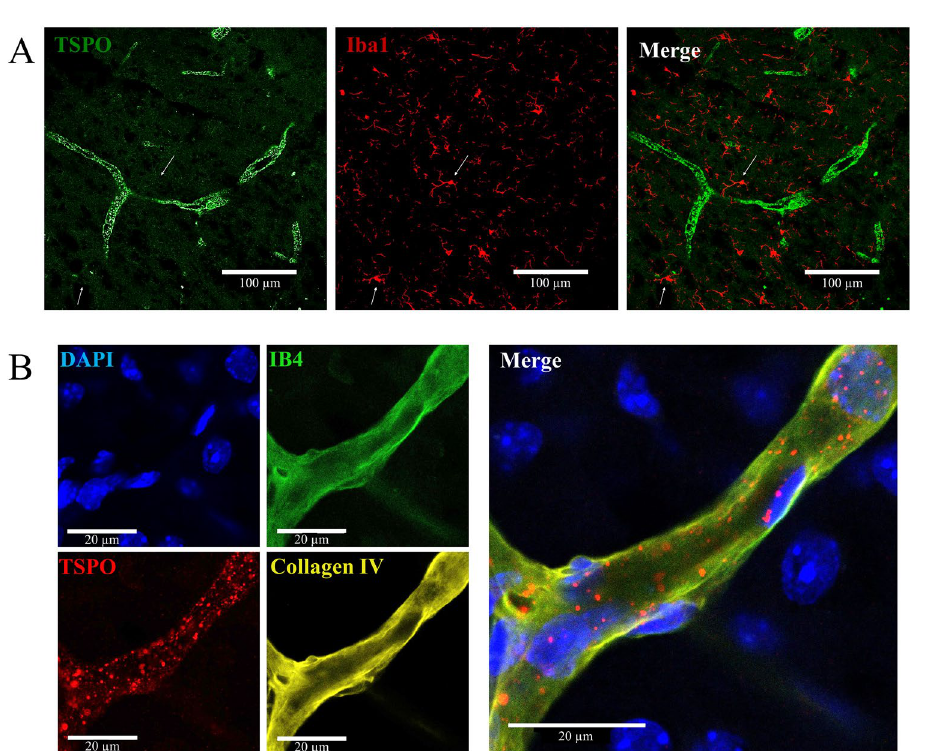
Figure 2. Immunohistochemistry on mouse brain slice 3 days post-TBI around ipsilateral cortical area, ( A ) Iba1/TSPO staining; ( B ) DAPI/TSPO/IB4/Collagen IV staining. TBI traumatic brain injury, TSPO translocator